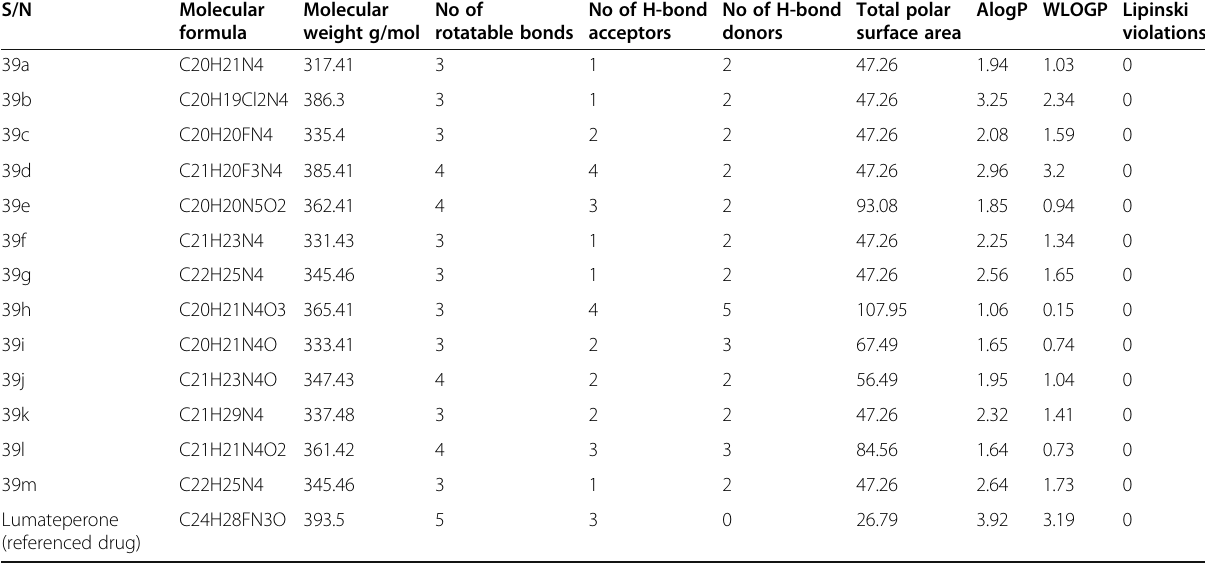
Table 2 Predicted physicochemical parameters of the designed inhibitors and a referenced drug (Lumateperone) S/N Molecular formula